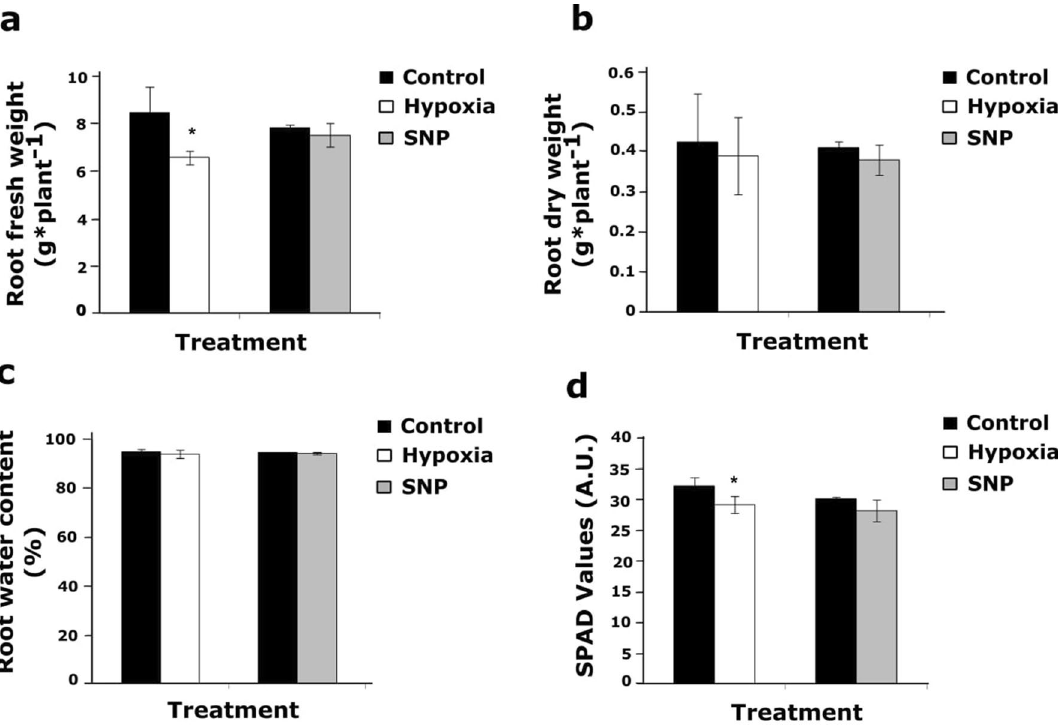
Figure 1. Fresh weight, dry weight and relative chlorophyll content of tomato plants in response to hypoxia and SNP-treatment. ( a ) Fresh weight; ( b ) dry weight and ( c ) water content (%) of 5 weeks old tomato roots after 48 h hypoxia and 48 h SNP-treatment were compared to their representative control. ( d ) Relative chlorophyll contents in leaf #3 of plants under hypoxia and SNP-treatment in comparison to their respective control are shown as SPAD values. Data represent means ± SD; n = 3 ; *significant differences (Student’s t test, *P < 0.05).